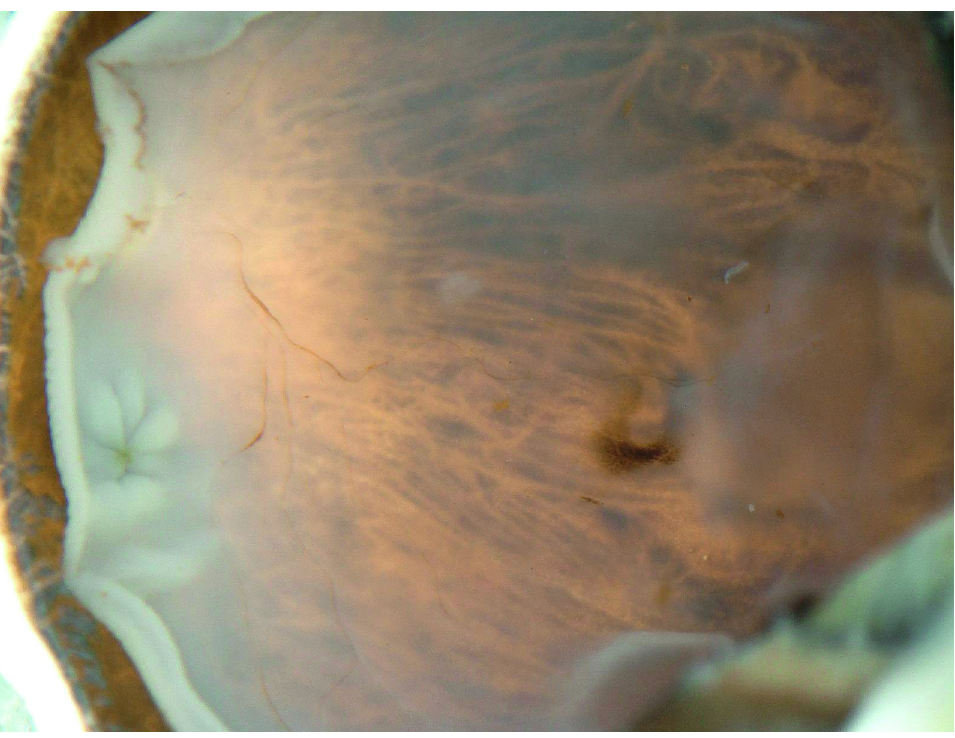
Fig 1. COVID-19 postmortem donor eye. Dissected donor eye depicts a detached retina, optic disc and retinal vessels prior to retinal dissection.